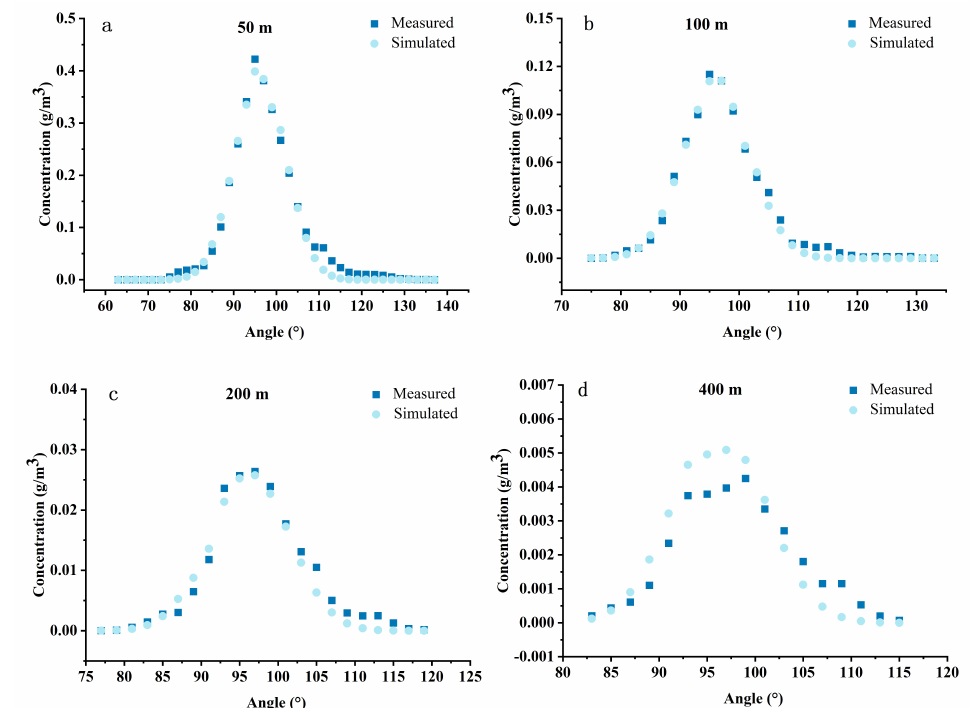
Figure 5. Simulated SO 2 concentrations through Gaussian plume model based on the parameters calculated by ACA–IPFM. Angle is the angle from the west direction, ( a ) is the measurements at 50 m radius of the SO 2 emission source, ( b ) is the measurements at 100 m radius of the SO 2 emission source, ( c ) is the measurements at 200 m radius of the SO 2 emission source, ( d ) is the measurements at 800 m radius of the SO 2 emission